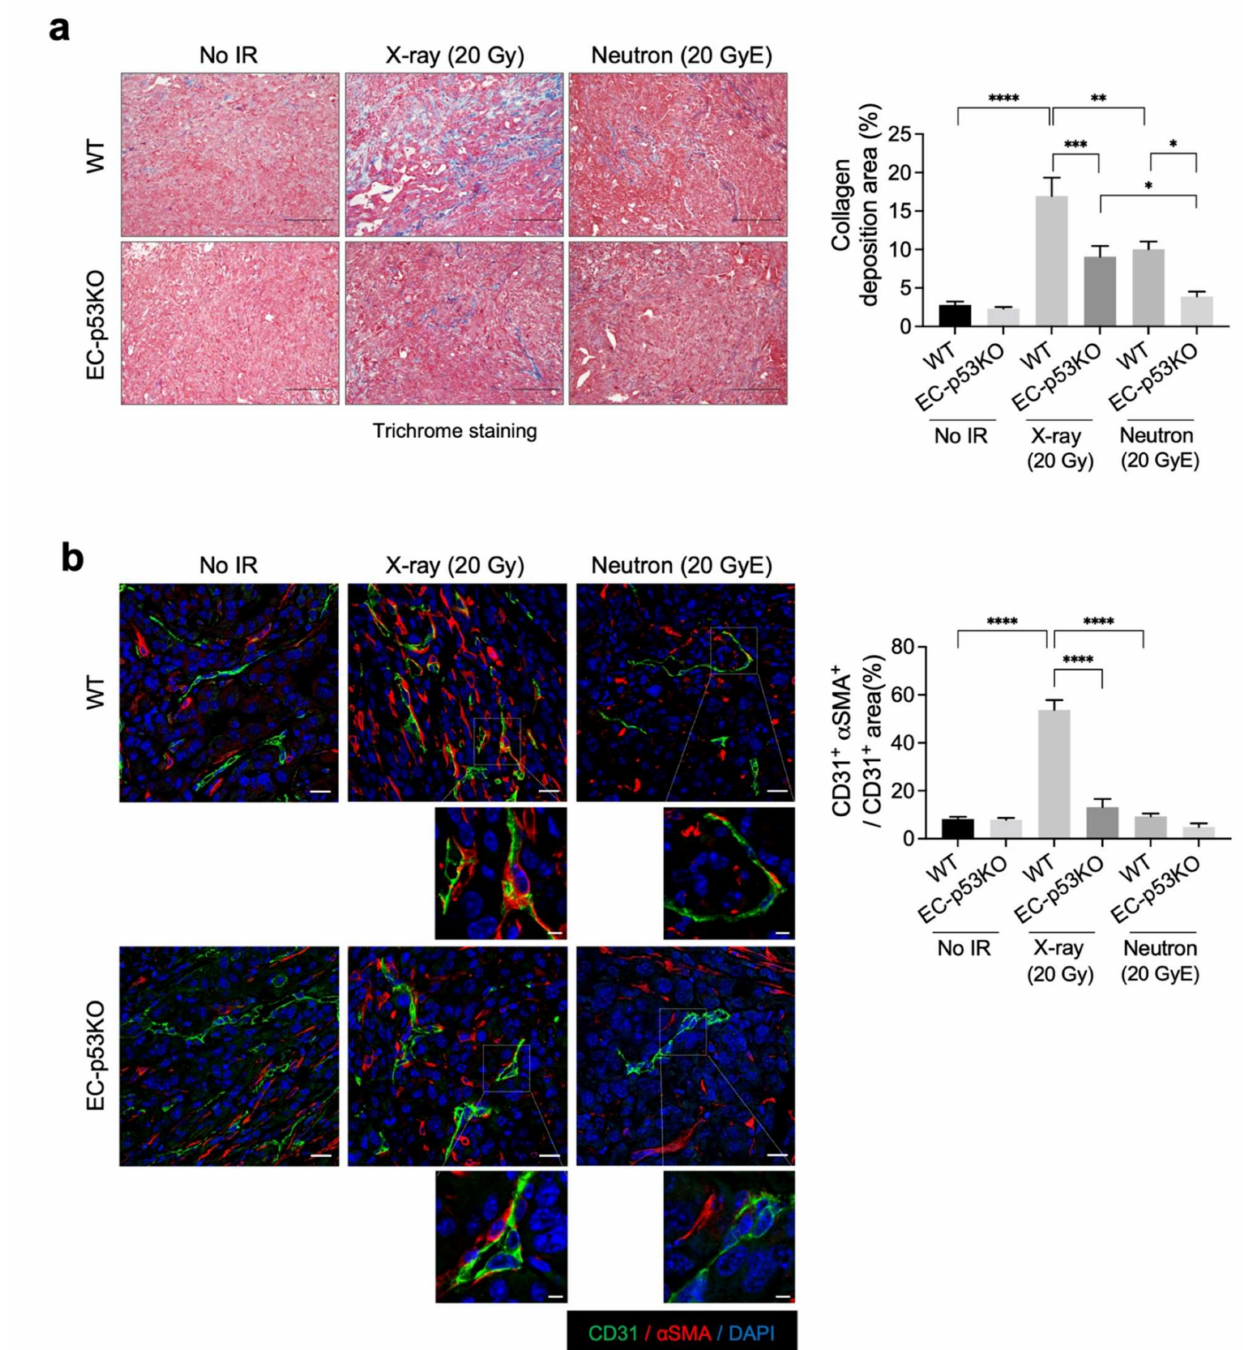
Figure 2. Lower collagen deposition is observed after neutron irradiation compared to X-ray irradiation, in addition to ENDMT suppression, in both WT and EC-p53KO mouse tumor models. Non-irradiated tumor tissues obtained on day 0 and tumor tissues obtained on day 15 after irradiation were used for staining. ( a ) Trichrome staining of irradiated or non-irradiated KP tumors from WT and EC-p53KO mice. Scale bar = 40 µ m. Quantification of collagen deposition area per field as an average of five fields (magnification, 200 × , n > 5). ( b ) Immunofluorescence staining of CD31 (green) and α SMA (red) expression in irradiated or non-irradiated KP tumors from WT and EC-p53KO mice. Scale bar = 20 µ m; scale bar of cropped images = 5 µ m. Quantification of the α SMA+CD31+ colocalization area relative to CD31+ area as an average of 5 fields (magnification, 200 × , n > 5). For all graphs, error bars indicate the SEM (one-way ANOVA for multiple comparisons). * p < 0.05, ** p < 0.01, *** p < 0.001 and **** p <